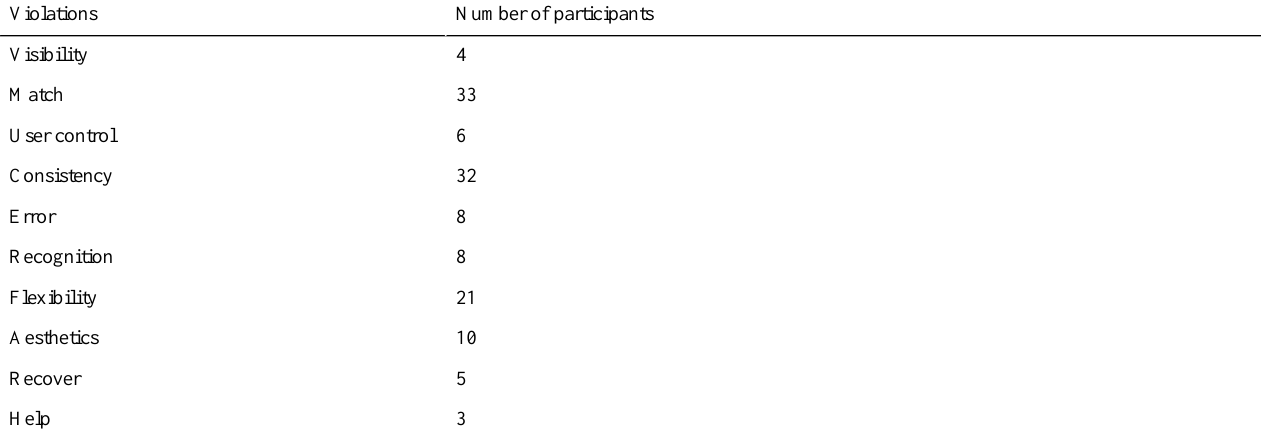
Table 1. Presentation of the frequencies of 10 heuristic violations sorted by Nielsen’s heuristics reported by the 15 participants. Number of